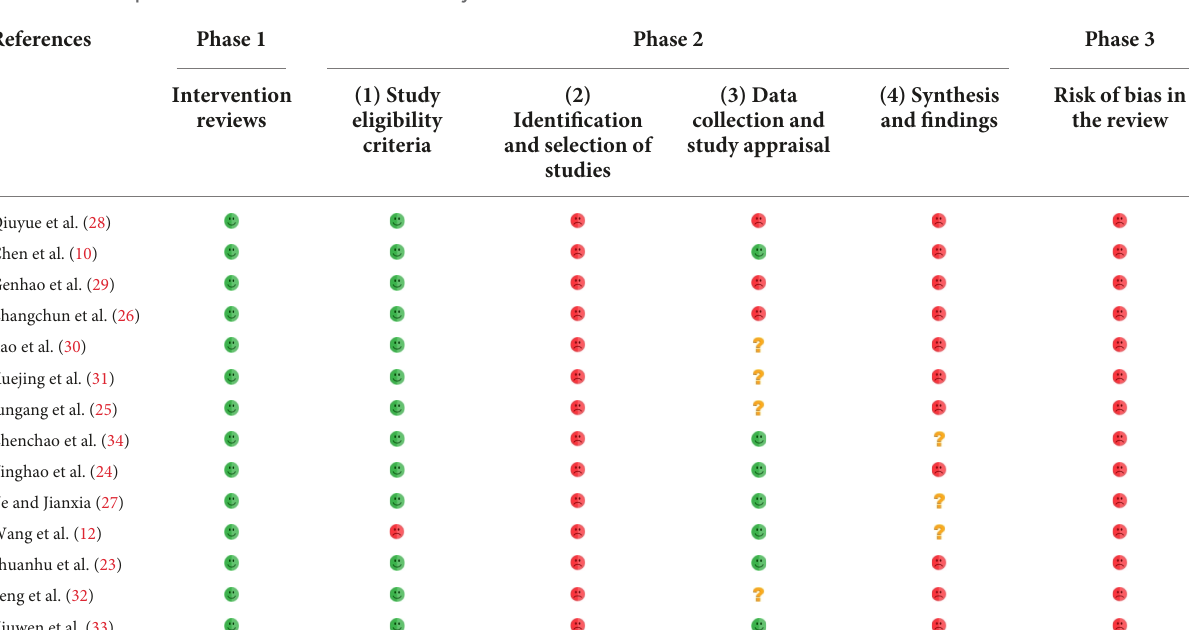
TABLE 4 Tabular presentation of risk of bias of included systematic